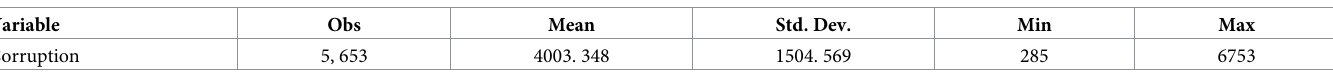
Table 2. Descriptive statistics of